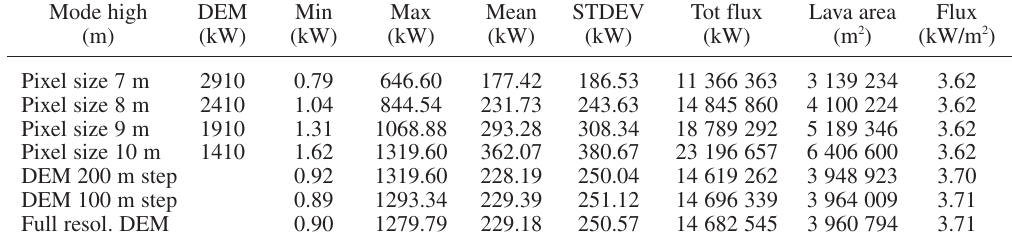
Table II. Energy flux statistics using different pixel-size values in flux calculation. DEM height is the topo- graphic altitude corresponding to the IFOV of the instrument, the flight altitude and the pixel-size we set. For the entire lava-flow system the max, min and mean values were calculated for the energy flux. We also retrieved the total flux for the entire flow, the area of the active lavas and the energy radiated from surface unit. Mode high DEM Min Max Mean STDEV Tot flux Lava area Flux (m) (kW) (kW) (kW) (kW) Pixel size 7 m